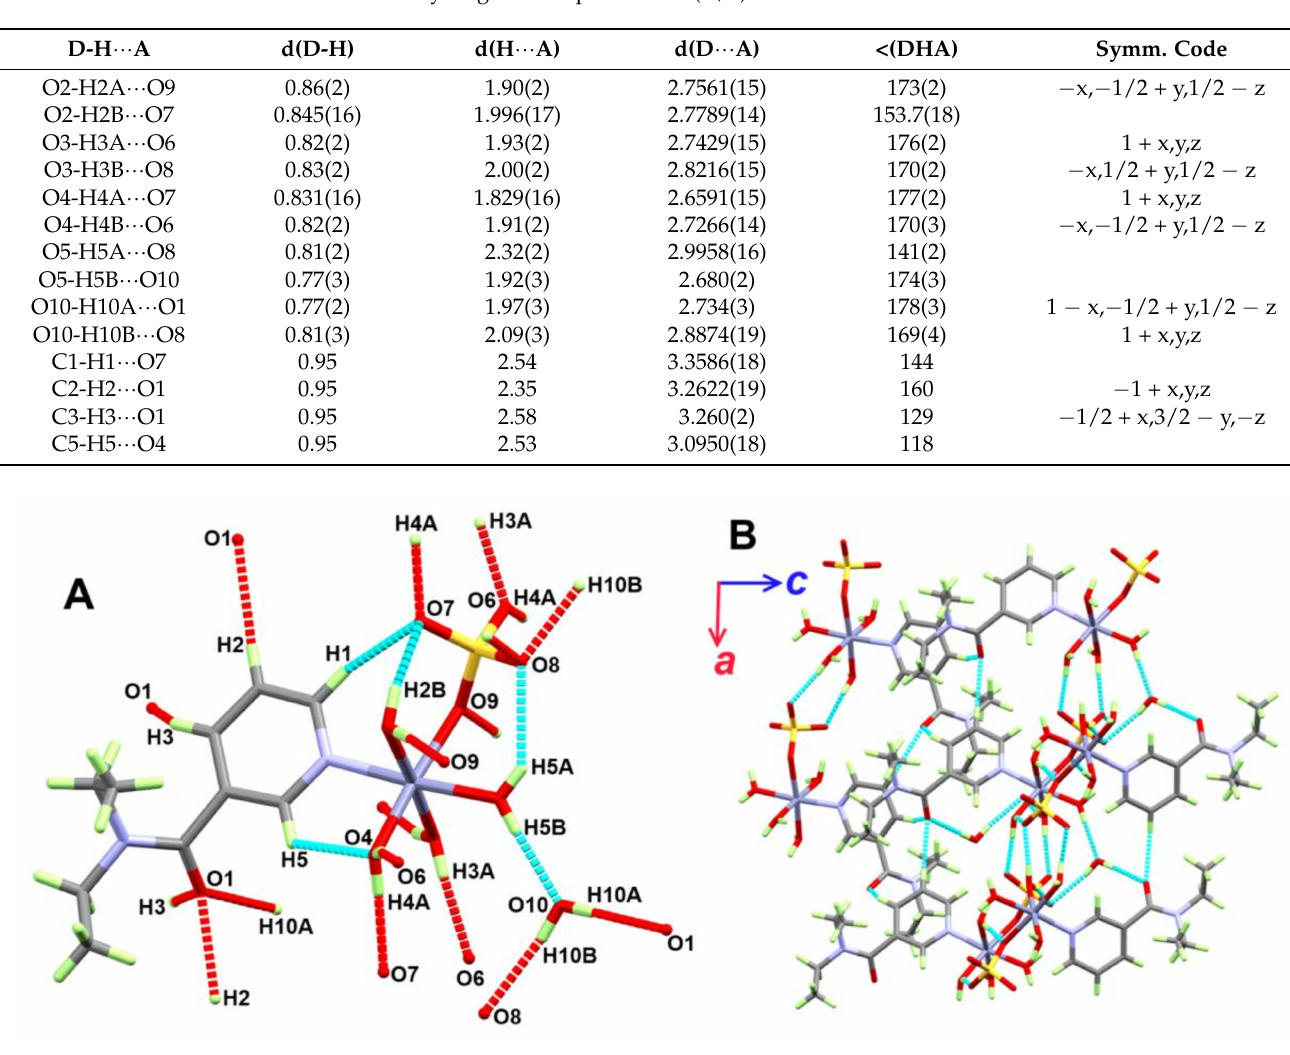
Table 3. Hydrogen bond parameters (Å, ◦ ) in 2 .